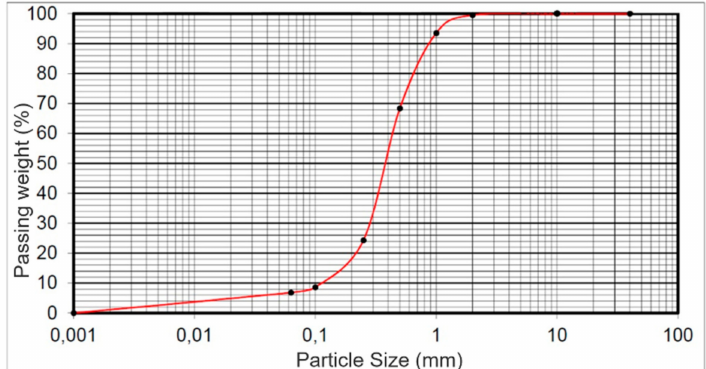
Figure 3. The sieve analysis result for medium sand according to